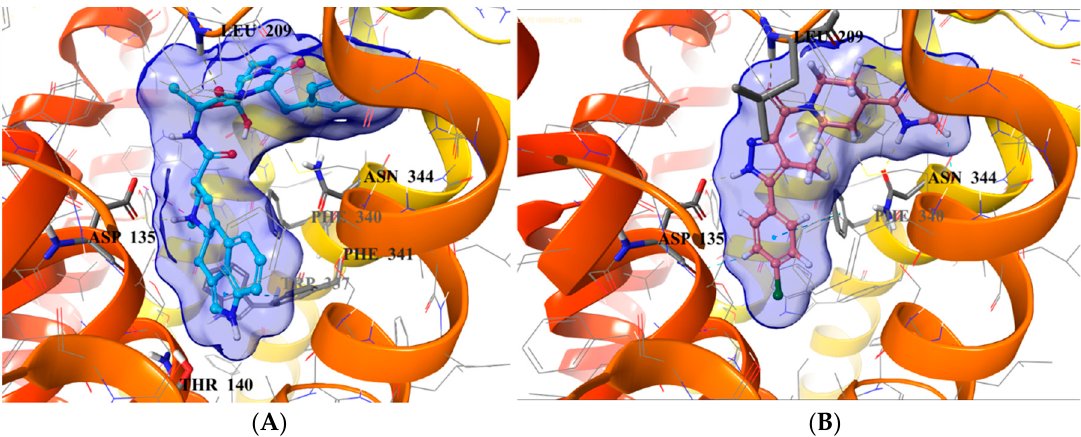
Figure 7. Two-dimensional (2D) interaction diagram of MCULE-7016689532 ( 8 ) in the 5-HT 2B R.